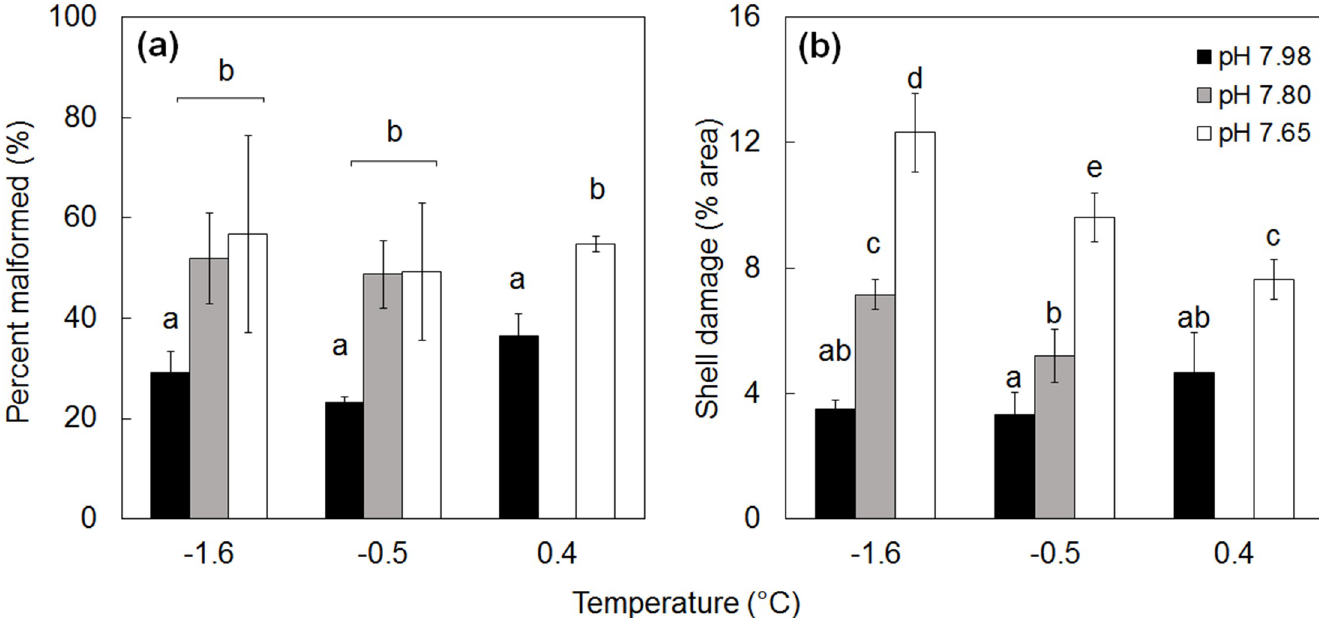
Fig 2. Treatment impacts on larval quality. ( a) Percentageof malformedD-shapedlarvaein each treatment and (b) shell quality assessment of normally shaped D-larvaefrom each treatment, where shell damage is equal to the percentage of the shell surface that is pitted, cracked or malformed. The letters above the columnsindicate significanceat p < 0.05. The temperature/pH combination of 0.4˚C/7.80 was not used, n = 3. Error bars are standard error.